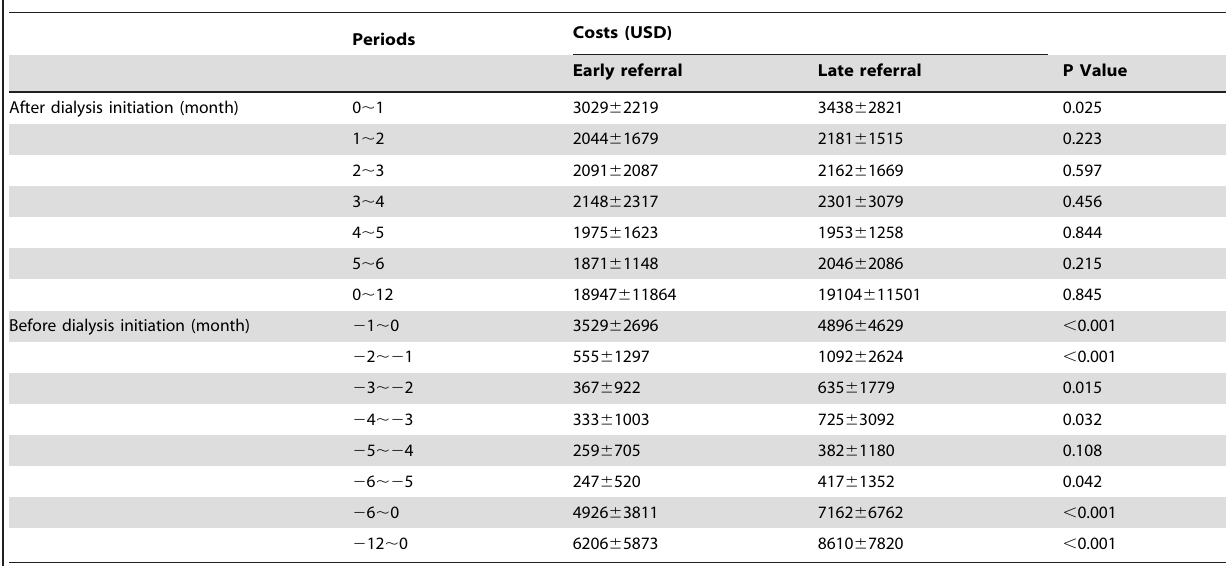
Table 2. Medical costs during the first year before and after dialysis therapy.